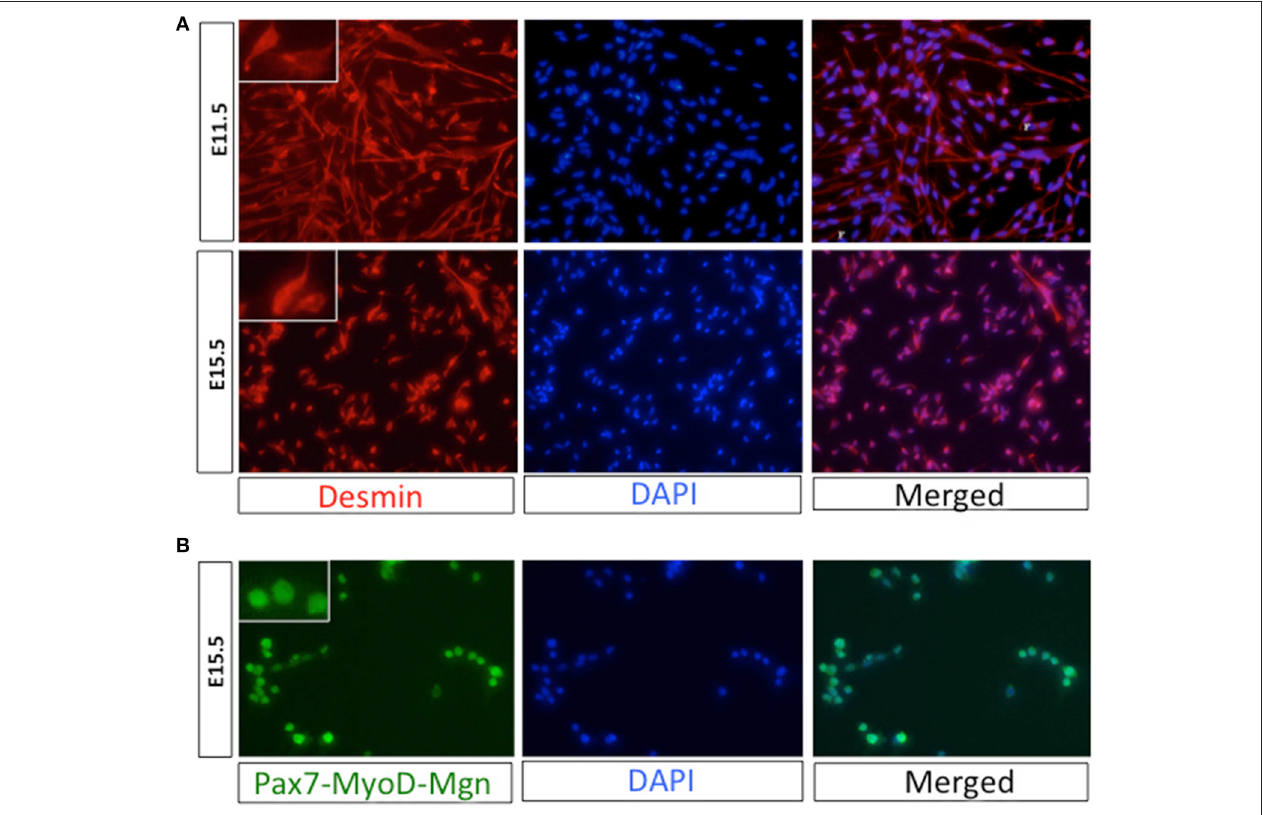
FIGURE 8 | Confirmation of the myogenicity of isolated progenitors. (A) Immediately after FACS isolation, cells from Myf5 GFP − P embryos (E11.5) or fetuses (E15.5) were plated on collagen-coated wells. Cells were fixed with 4% (wt/vol) paraformaldehyde 12h after plating and were stained with antibodies recognizing desmin according to standard protocols. (B) Cells FACS-purified from the limbs of Pax7-ICN Cre / wt ; Z/RED mut / wt fetuses (E15.5) were plated on ECM-coated glass chamber slides, fixed as in (A) and stained with a cocktail of antibodies against Pax7, MyoD, and Myogenin (Mgn). A high magnification picture of individual cells is shown in the insets. DAPI was used to stain nuclei.